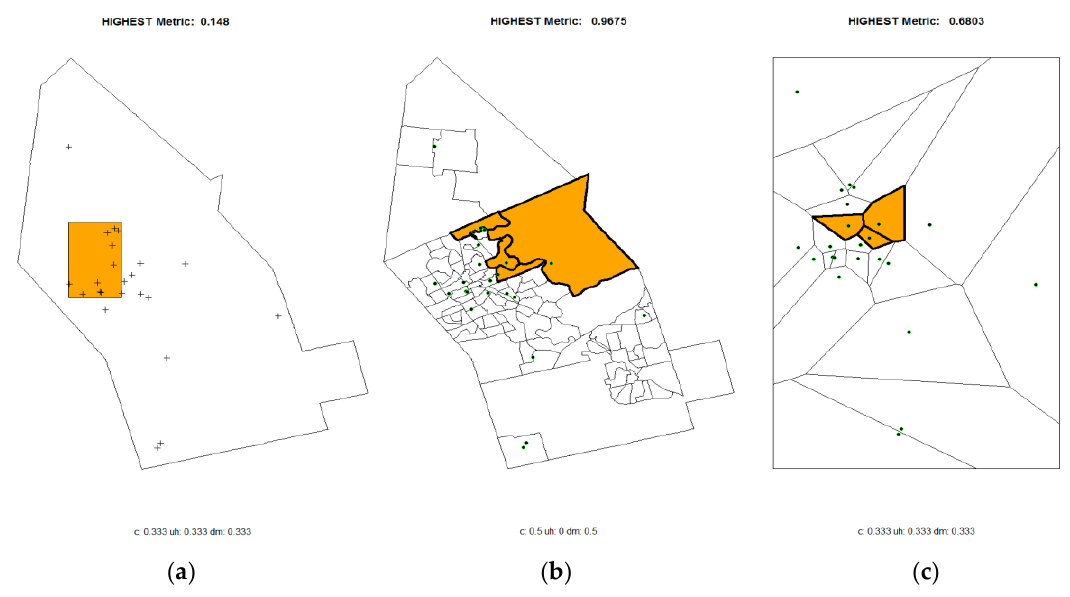
Figure 4. Three types of tessellations: ( a ) quadtree gridded polygons are used left, ( b ) census tracts centre, and ( c ) Voronoi polygons right.